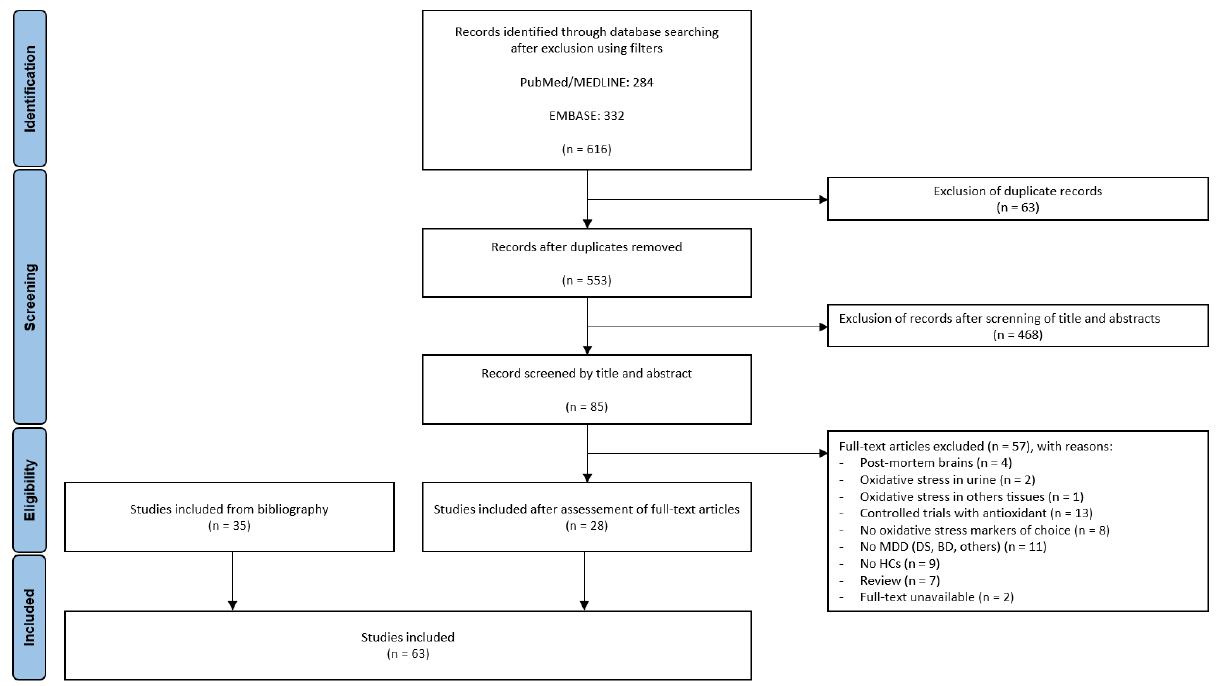
Figure 1. The PRISMA flowchart.